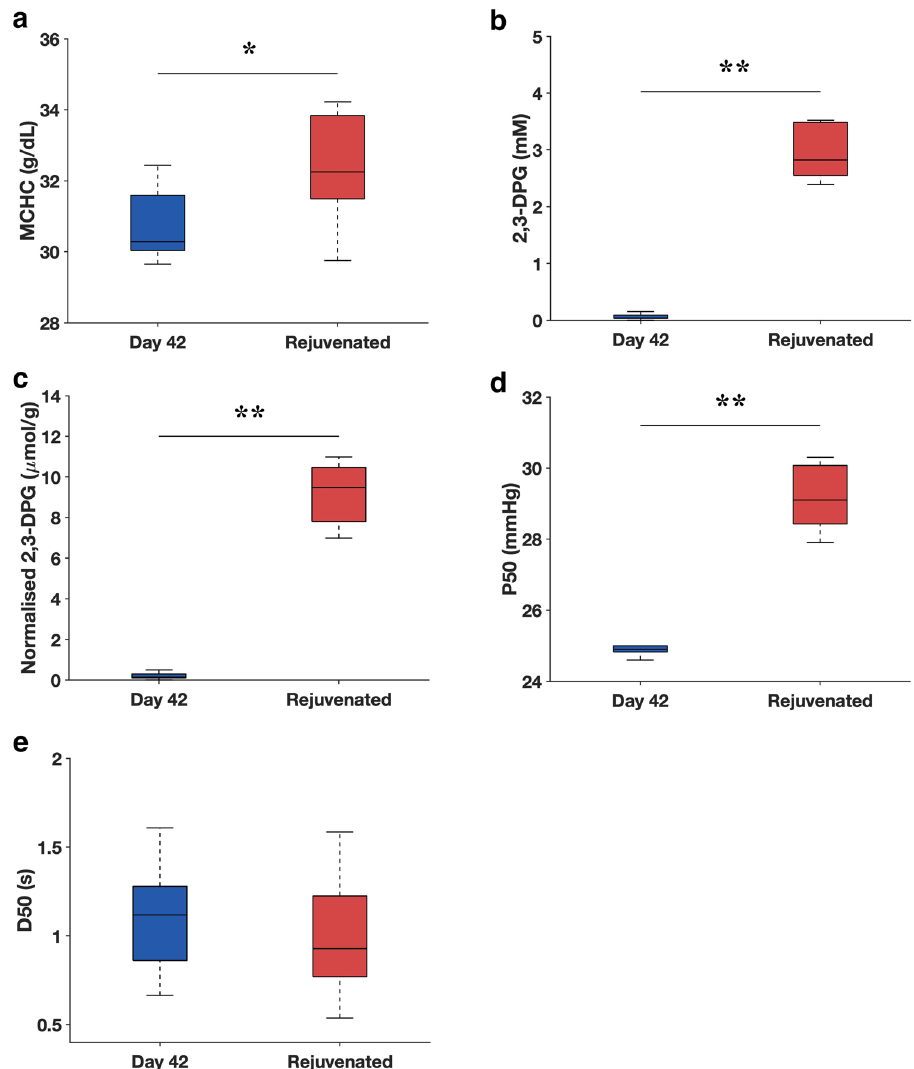
Fig. 5 Effect of intracellular 2,3-DPG rejuvenation on the O 2 release rate of RBCs stored for 42 days. a – d MCHC, absolute 2,3-DPG, normalized 2,3- DPG, and P50 before and after rejuvenation ( n = 5 of biologically independent samples). e D50 of RBCs before ( n = 65 of biologically independent RBCs) and after rejuvenation ( n = 93 of biologically independent RBCs). * P < 0.05, ** P < 0.001. The central mark of the boxplot indicates the median, and the bottom and top edges of the box indicate the 25th and 75th percentiles, respectively. The whiskers extend to the most extreme data points not considered